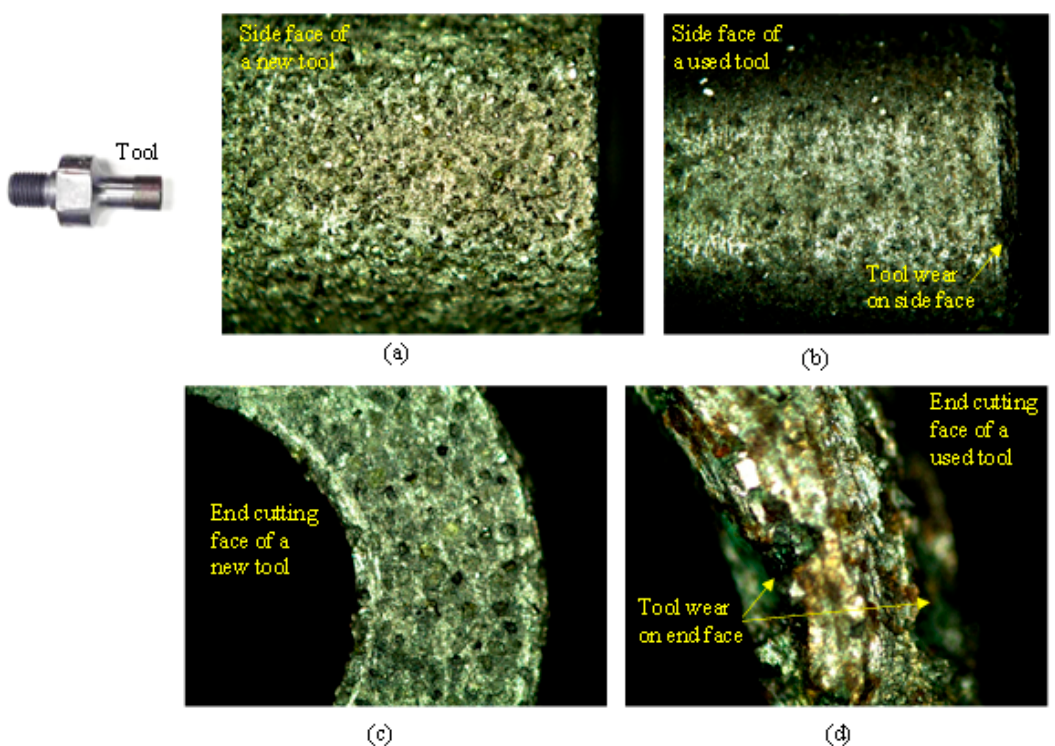
Figure 3. ( a ) Three different diameters of metal bonded diamond drills used in experiments; ( b ) Zoomed-in view of a metal bonded drill.